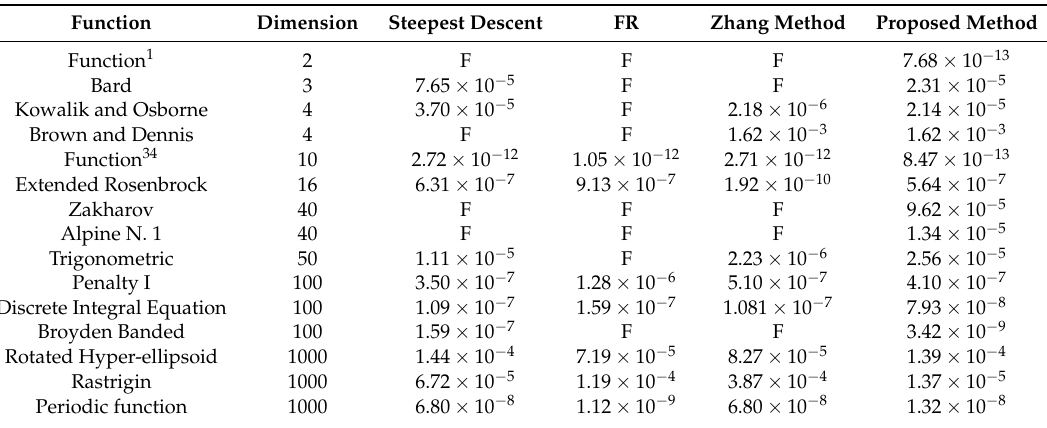
Table 5. Accuracy (error) for different